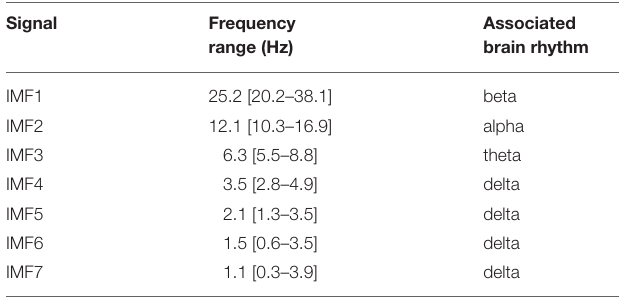
TABLE 1 | Frequency range in seven IMFs of